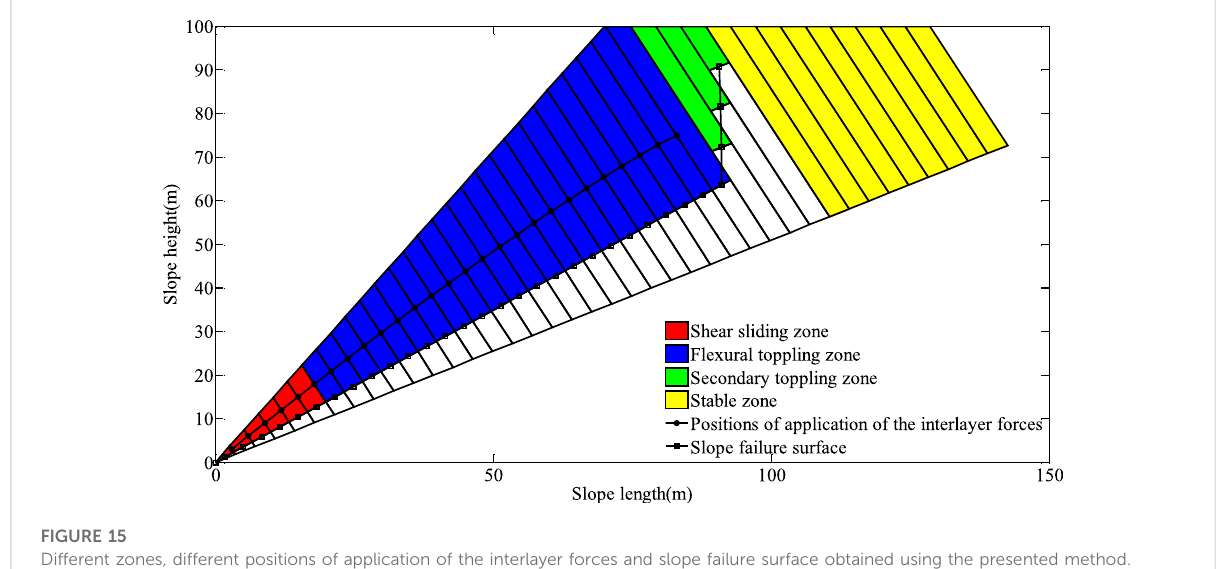
FIGURE 15 Different zones, different positions of application of the interlayer forces and slope failure surface obtained using the presented method.